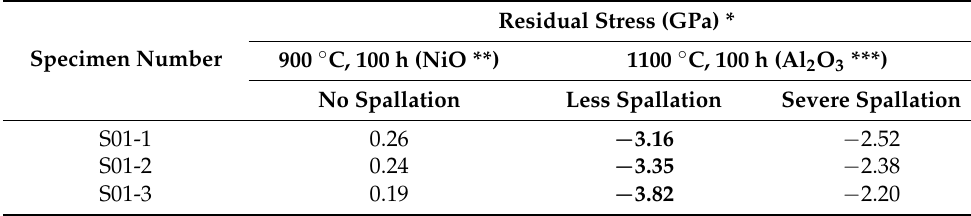
Table 2. Residual stresses (GPa) in the oxide scales of the studied alloy specimens with different